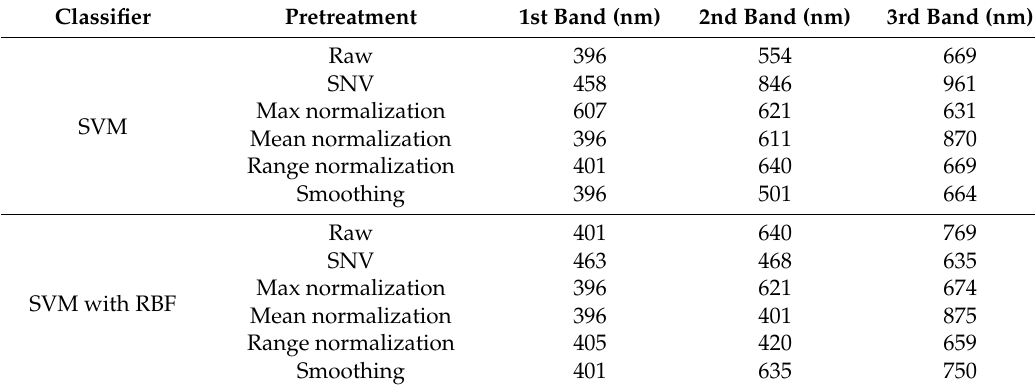
Figure 3. Mean spectra of diseased and sound (non-diseased) rice seeds and standard deviation bars after preprocessing with the standard normal variate (SNV) method. Table 2. Wavelengths of the three most important bands determined by the sequential forward selection (SFS) method following various classifier pretreatments.